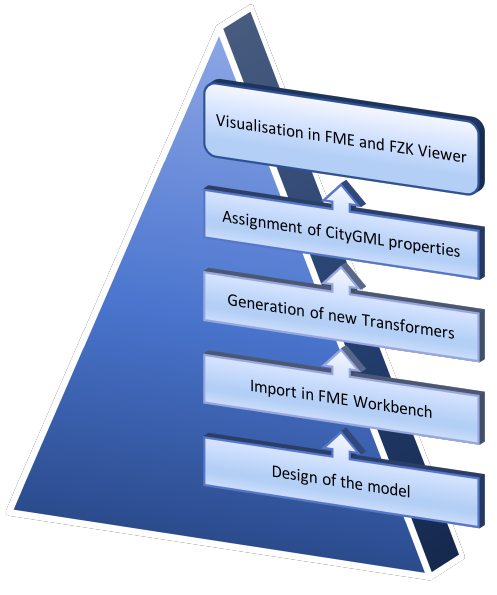
Figure 1: Workflow of the